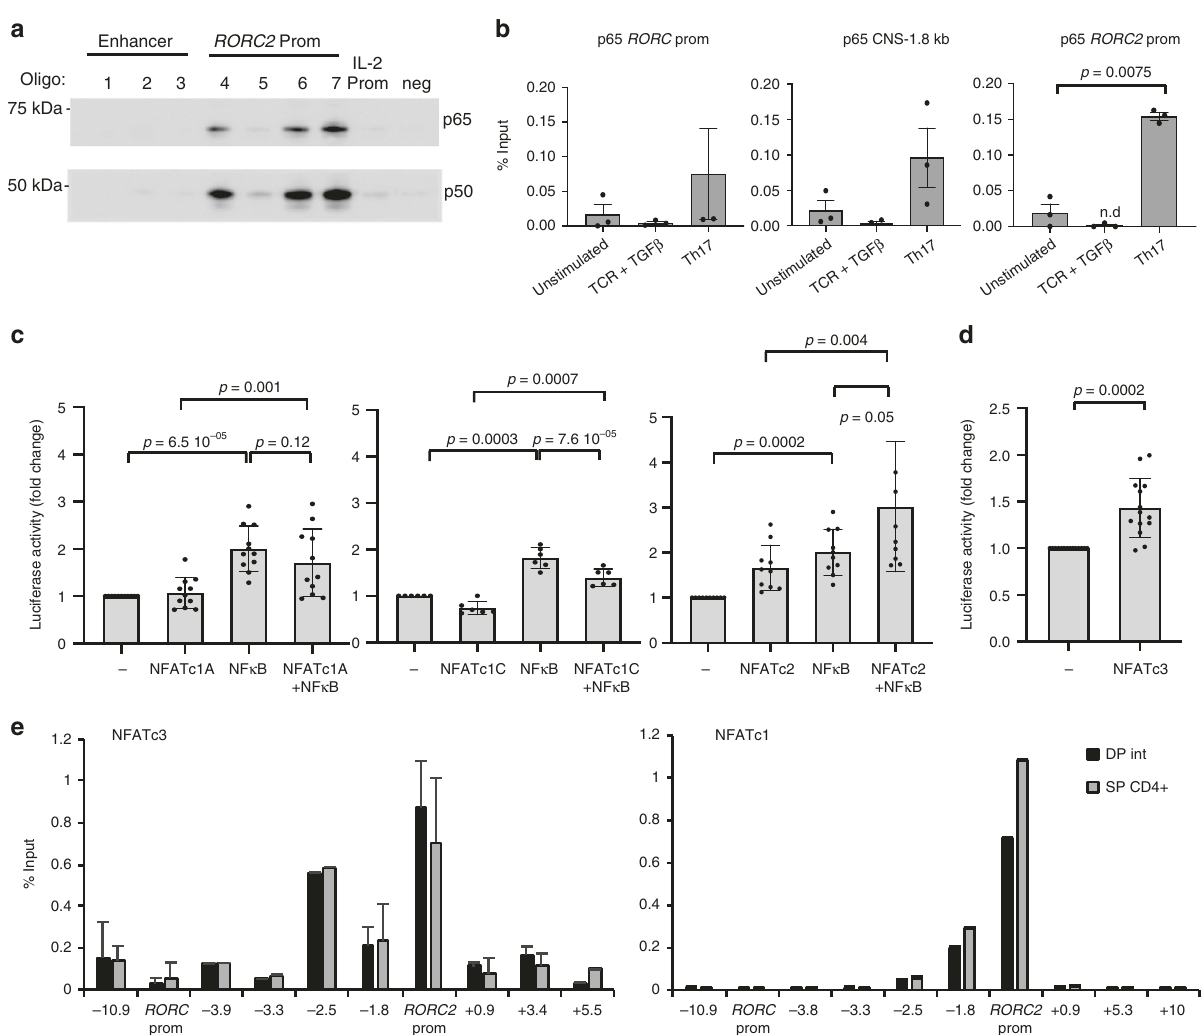
Fig. 8 NF-kB cooperates with NFAT in activating RORC 2 transcription. a NF-kB proteins bind to the RORC 2 promoter in vitro. DNA af fi nity capture assay was performed in Jurkat E6.1 cells with biotinylated oligos encompassing the NFAT binding sites (see Fig. 5). Western blot of the DNA-bound proteins was probed with anti-p65 and anti-p50 antibodies. IL - 2 prom : NFAT binding site from the IL - 2 promoter, neg : sequence in the RORC locus with no NFAT binding site. b NF-kB binds to the human RORC locus in stimulated CD4 + T cells in vivo. CD4 + T cells from cord blood were stimulated for 20h in the indicated conditions. ChIP was performed with an anti-p65 antibody, followed by RT-qPCR of the RORC promoters and CNS-1.8 kb enhancer region. Data are shown as percent of input, after subtraction of the irrelevant IgG background and represent average and SD of 3 experiments. n.d.: not detected. c NF-kB cooperates with NFAT to activate transcription from the human RORC 2 promoter. HEK293T cells were transfected with expression vectors for p65 and p50 (NF-kB) or the indicated NFAT transcription factors, together with a RORC2 promoter construct. Normalized transcriptional activity is represented as fold changes over the activity of the RORC 2 promoter alone ( fi rst bars). Data shown represent average and SD of 11, 6 and 10 independent experiments (for left, middle and right graphs respectively). d NFATc3 activates transcription from the RORC 2 promoter. HEK293T cells were transfected with the RORC 2 promoter in the presence or absence of NFATc3. Luciferase activity was measured after 20h and represented as fold change relative to activity of the RORC 2 promoter alone ( fi rst bar). Plotted are average and SD from 14 transfections. e NFATc3 binds to the RORC locus. Extracts from sorted DPint and SP CD4 + thymocytes were subjected to chromatin immunoprecipitation with anti-NFATc3 antibodies (left panel, average and SD of 2 – 4 replicates for the different regions) and anti-NFATc1 antibodies (right panel, one representative experiment). NFAT enrichment is represented as percentage of input after background subtraction. Shown are the p-values from two-tailed t -tests performed between the indicated conditions. Source data are provided as a Source Data fi